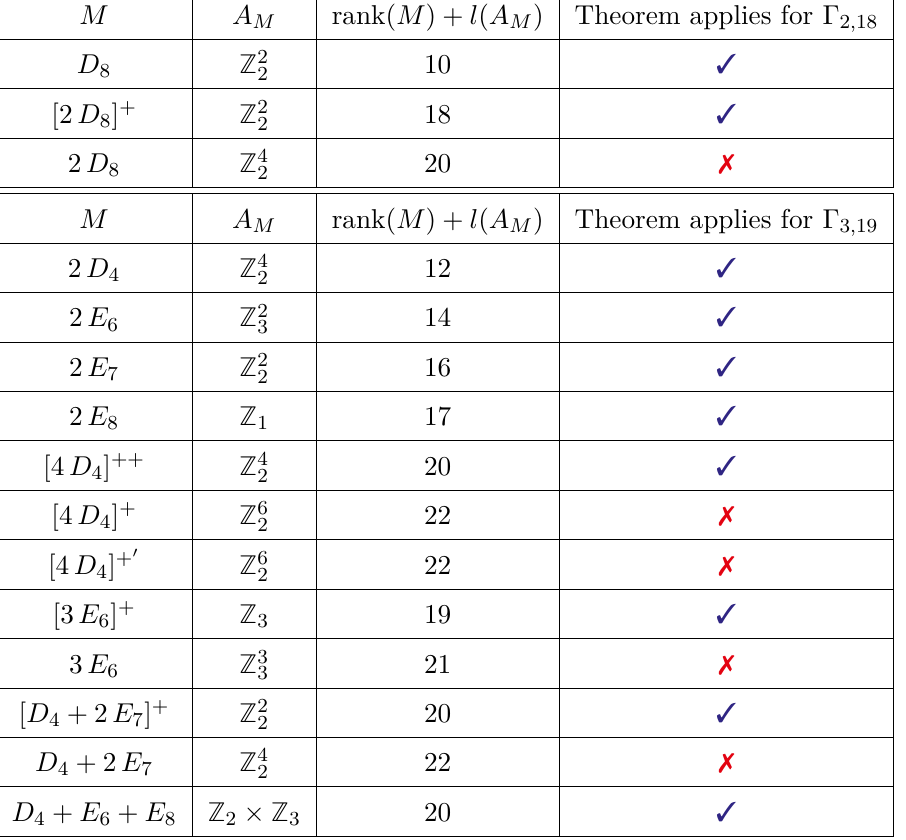
Table 2 . Lattices which define moduli space components of string theories with 16 supercharges in eight and seven dimensions, embedded respectively into Γ 2 , 18 and Γ 3 , 19 , together with their discriminant groups and values for the sum of the rank and minimal number of discriminant group generators. The last column indicates if the embedding uniqueness is guaranteed by Nikulin’s theorem. The pluses indicate extensions to weight lattices (cf. table